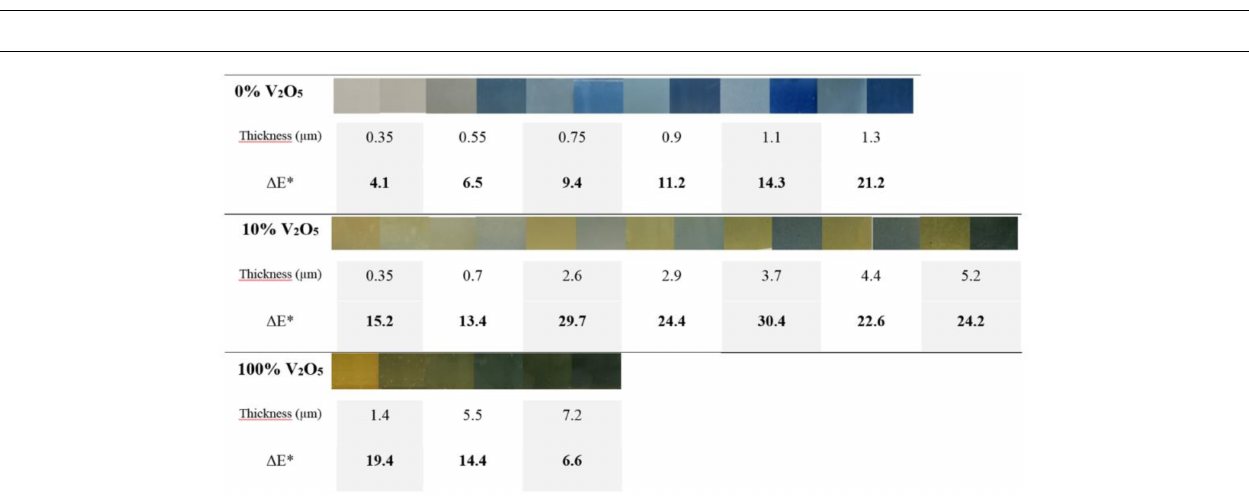
FIGURE 10 | Visual comparison between the colors in the oxidized and reduced states for 0 wt% V 2 O 5 , 100 wt% V 2 O 5 , and 90 wt%–10 wt% PEDOT:PSS-V 2 O 5 vs. thickness ( µ m) during CA after three cycles and contrast value (cid:49) E*.